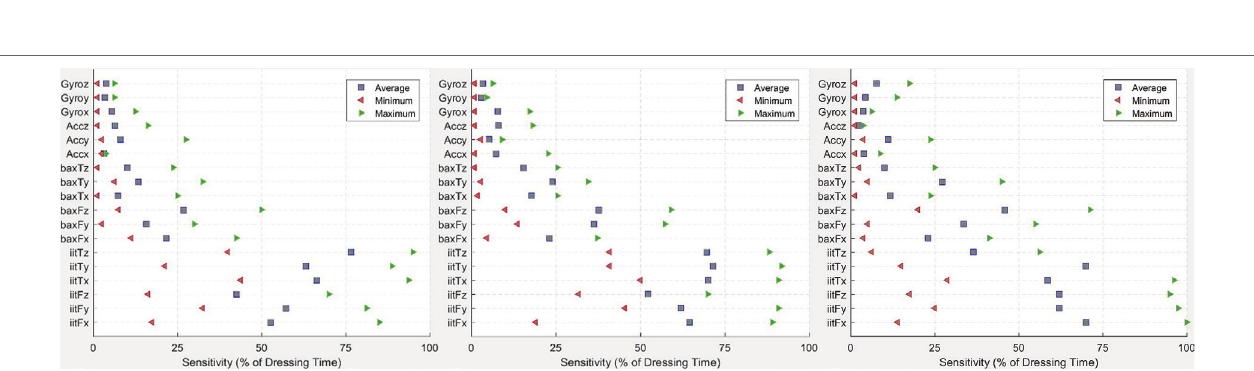
FigUre 9 | sensitivity chart showing the minimum, maximum, and average percentage of dressing time without overlap of the confidence intervals between base layers for poses 1–3 (left to right) .